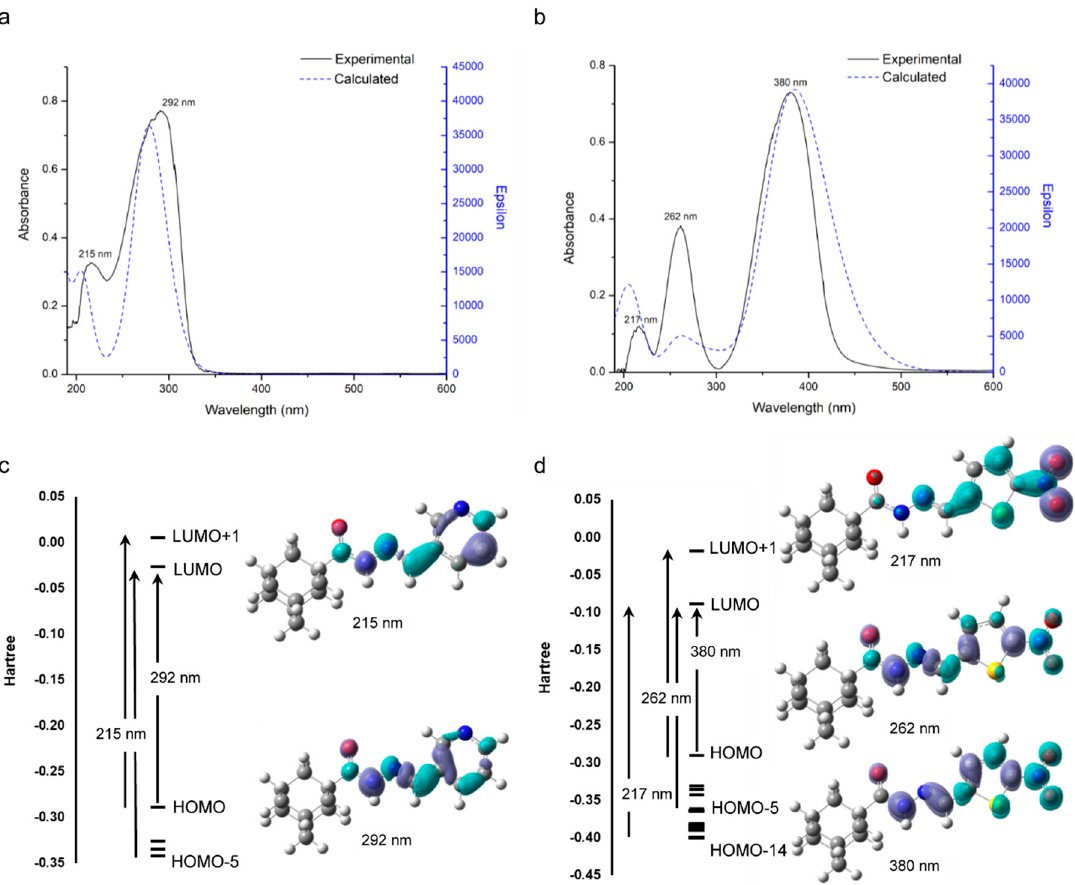
Figure 9. UV-vis spectra of a 10 μ g/mL methanolic solution of 1 ( a ) and 2 ( b ). Experimental and calculated spectra (CAM-B3LYP-SMD/6-311+G(d,p)) are depicted as solid and dashed lines, respectively. For the theoretical spectra, the half-width at half-height is 0.333 eV. In ( c ) and ( d ), the molecular orbitals involved in the different electronic transitions and their energies are shown for both systems. The electron density difference maps (EDDM) associated with the electronic transitions are also depicted. The electron density changes from purple to cyan upon light absorption. Atom color code: C (grey), H (white), O (red), N (blue), S (yellow).